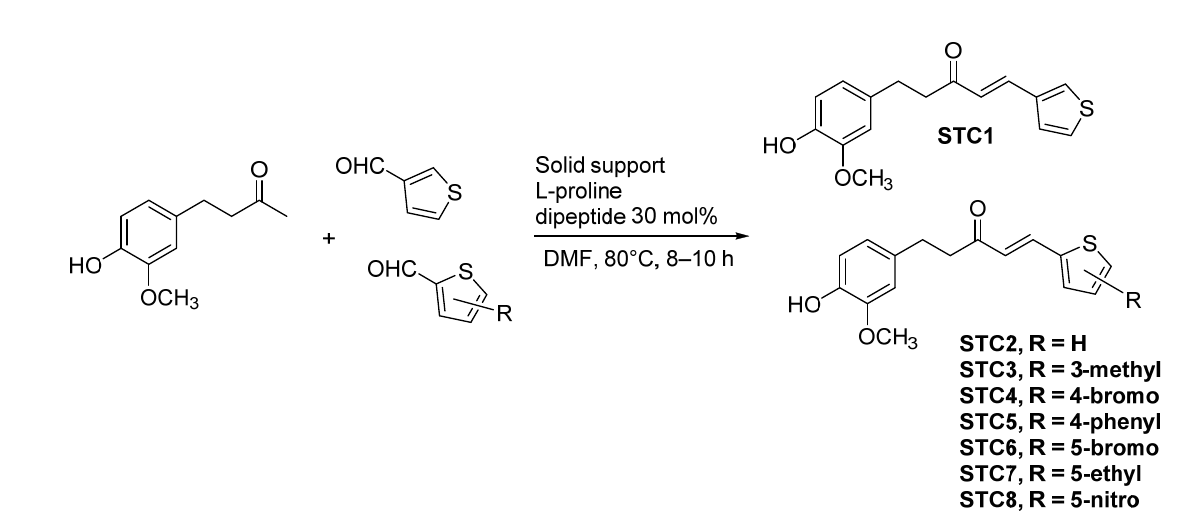
Figure 2. Synthetic scheme for the preparation of shogaol thiophene compounds.